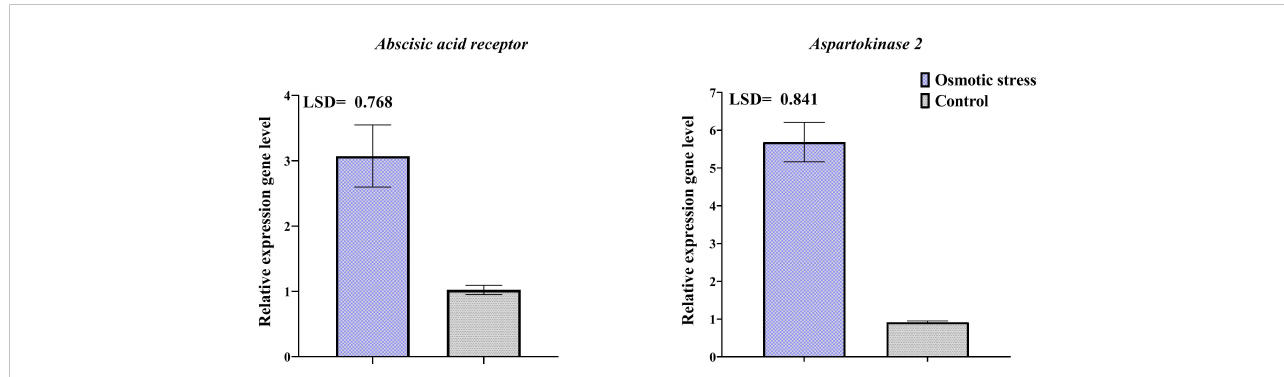
FIGURE 6 Transcriptional expression levels of two differentially abundant proteins in pistachio leaves in response to osmotic stress based on qRT-PCR analysis results. Error bars indicated the SD (n = 3) Statistic were carried out at p = 0.05 according to the LSD